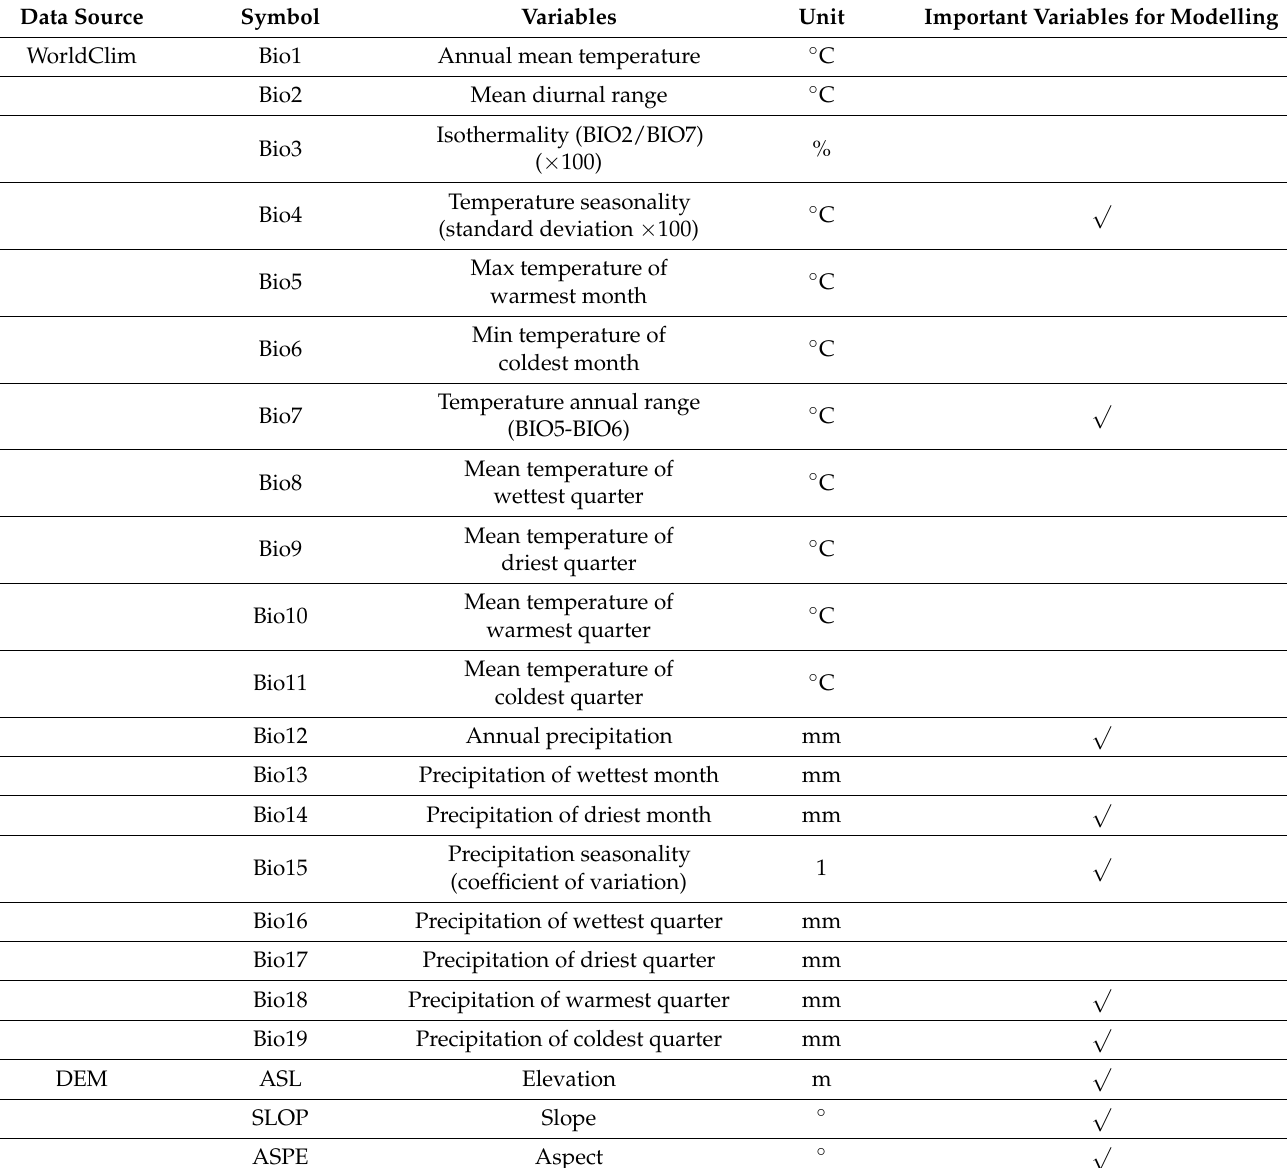
Table 1. The selection of environmental variables used in this